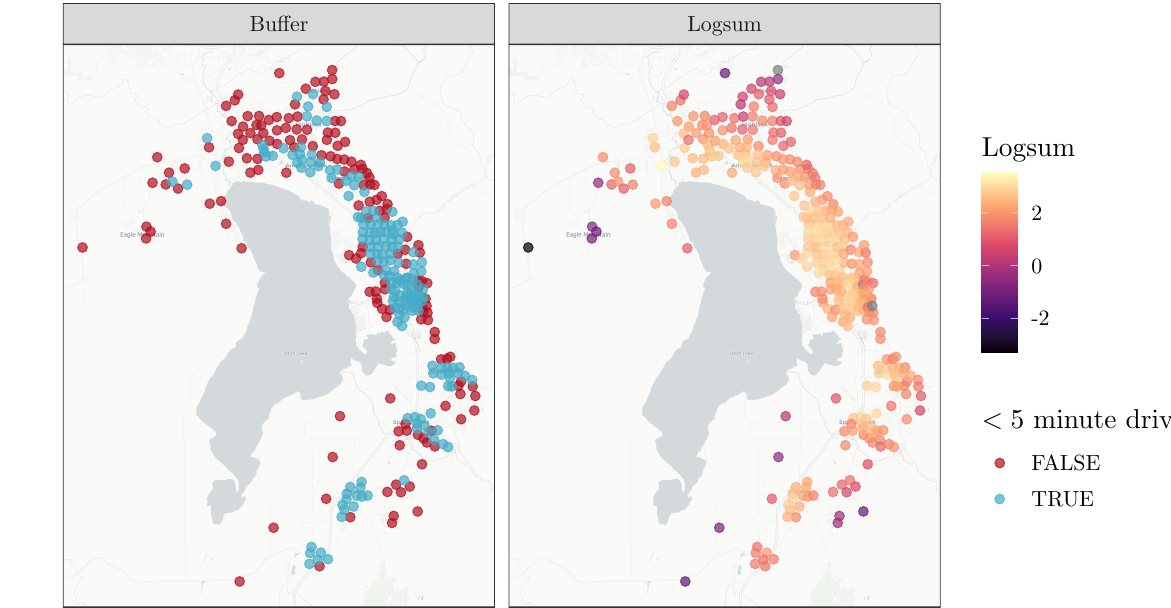
Figure 3. Spatial comparison of grocery access threshold versus logsum